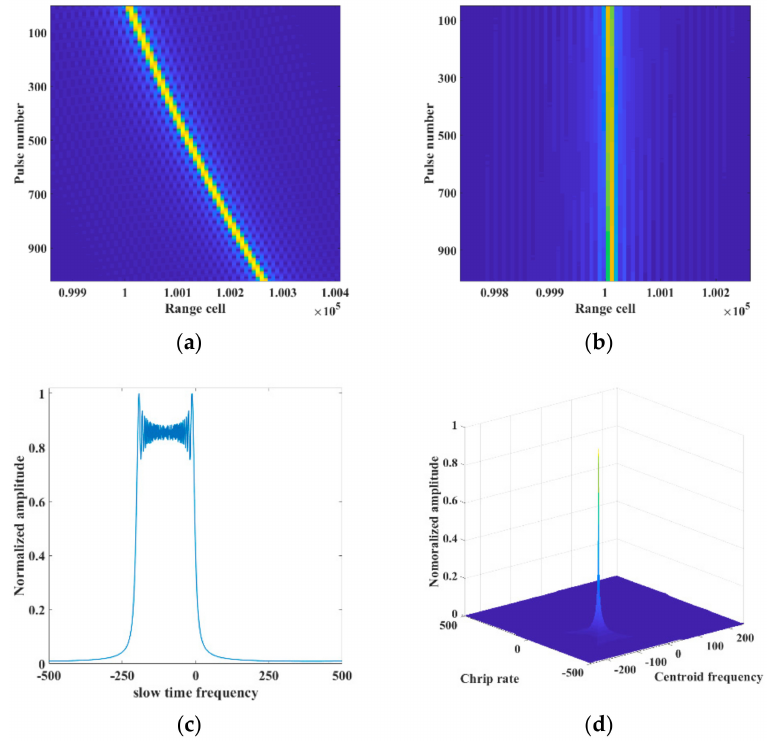
Figure 3. Migration correction effect of the proposed method: ( a ) Signal after pulse compression; ( b ) Signal after LRM and QRM correction; ( c ) The frequency spectrum of the extracted signal after RM correction; ( d ) Signal in CFCR domain after LVD